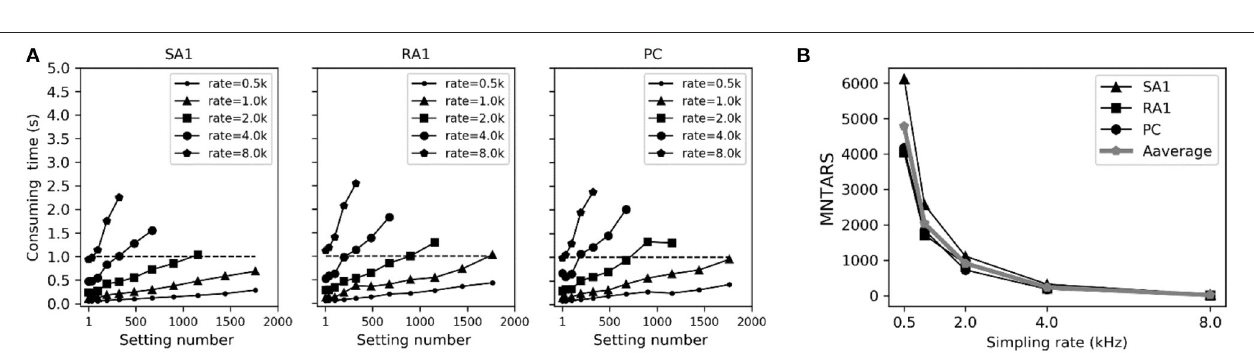
FIGURE 6 | Evaluation of spike-timing precision for each afferent type. (A) Recorded (gray dotted marks) and simulated spike trains of 5 sampled tactile units for each afferent type in response to a sinusoidal stimulus of 20Hz vibration (black solid line) with amplitudes of 35 (left), 130 (center) and 250 um (right). Recorded spike trains and the stimulus were adapted from Muniak et al. (2007). (B) Difference in the spike distance between the simulated and jittered spike trains to recorded spike trains as a function of jitter SD. The vertical black dotted line localizing at the cross of zero horizontal line and the quadratic fitting curve of current model determine the timing precision.